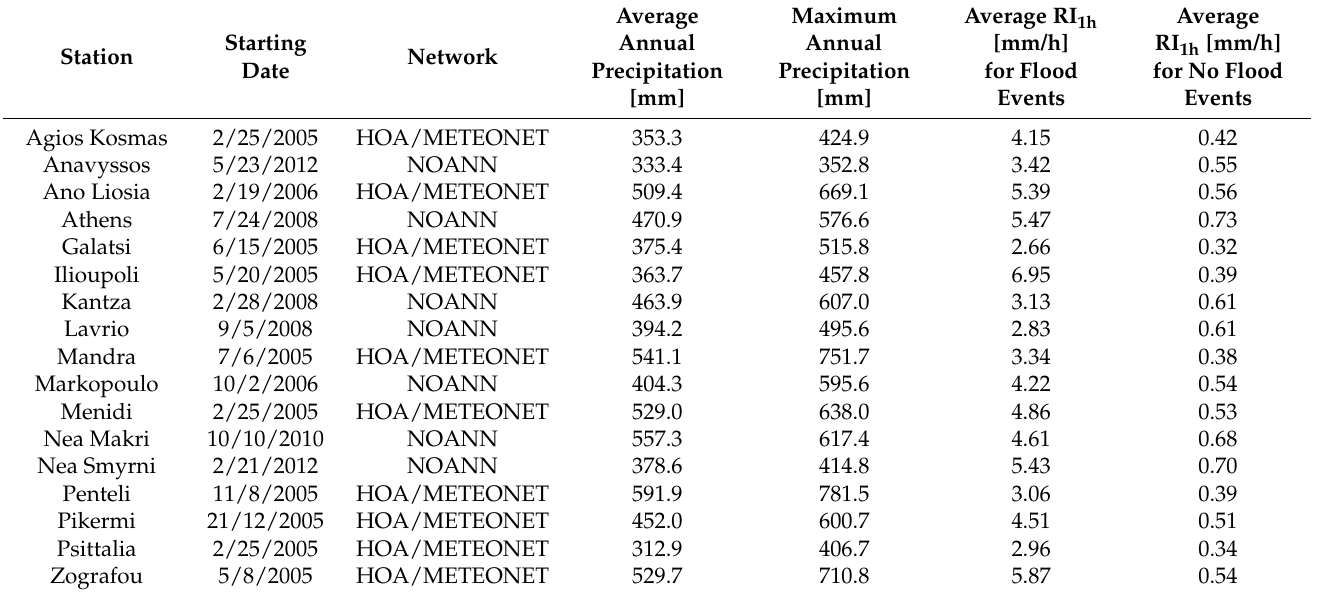
Table 1. Main characteristics of the selected rain